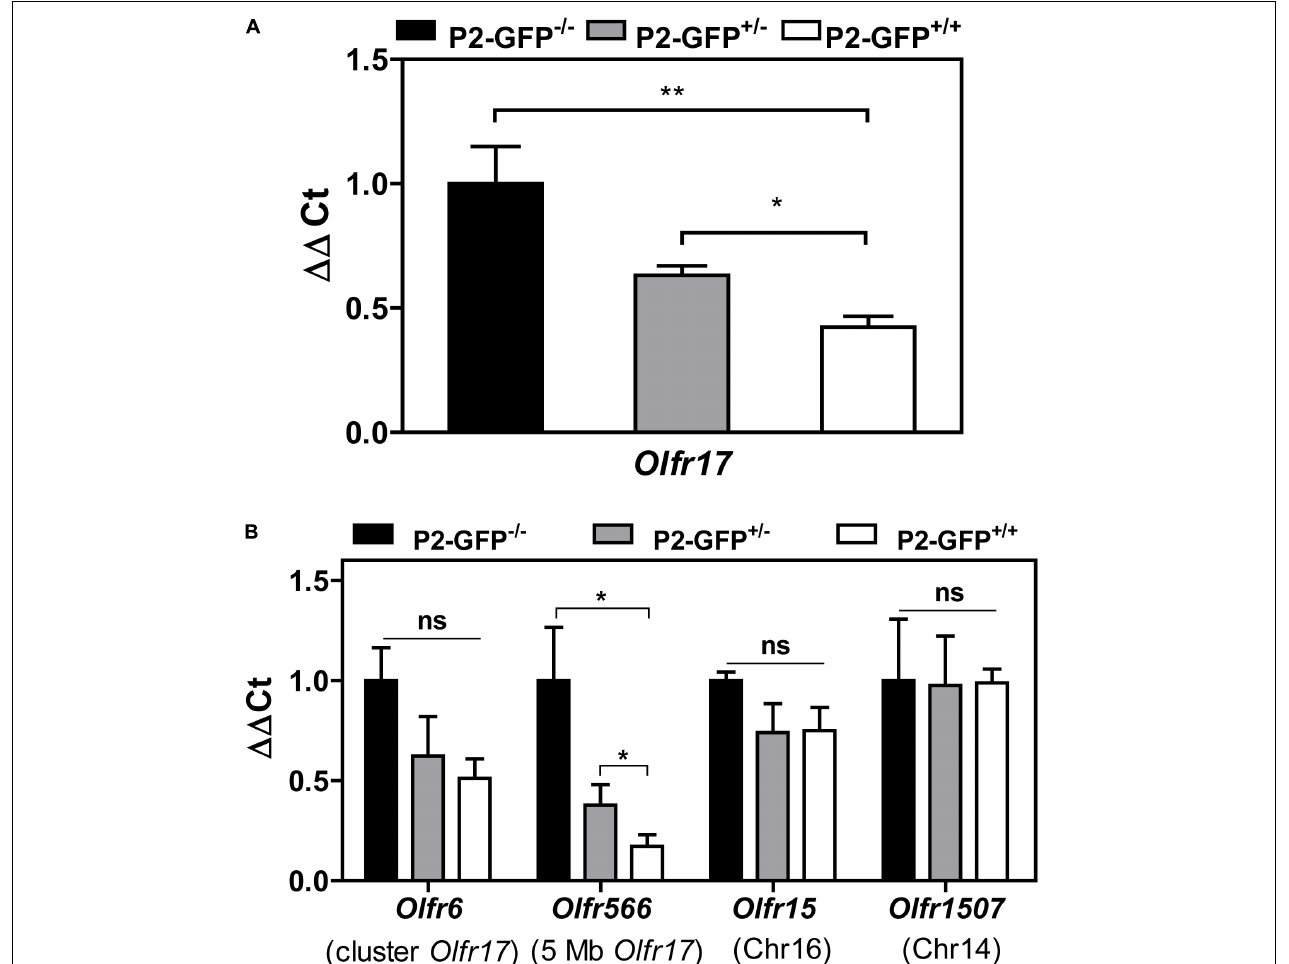
FIGURE 5 | Expression of OR genes located close to Olfr17 or in other chromosomes in the P2-GFP mice. (A) RT-qPCR was performed to determine the relative Olfr17 gene transcript levels in the olfactory epithelium from P2-GFP − / − ; P2-GFP + / − and P2-GFP + / + mice. The levels were normalized to β -actin and are shown relative to the expression in homozygous olfactory epithelium. Graph shows mean +/ − SEM (P2-GFP + / + , n = 5; P2-GFP + / − , n = 4; P2-GFP − / − , n = 5). * P < 0.05; ** P < 0.01. One-way ANOVA followed by Newman–Keuls post hoc test or student’s t -test. (B) RT-qPCR and the same cDNAs as in (A) were used to determine the relative transcript levels of Olfr6 , Olfr566 , Olfr15 , and Olfr1507 . Graph shows mean +/ − SEM [P2-GFP + / + , n = 3 ( n = 4 for Olfr6 and Olfr15 ); P2-GFP + / − , n = 4 ( n = 3 for Olfr1507 ); P2-GFP − / − , n = 3]. Not significant: ns, * P < 0.05. One-way ANOVA followed by Newman–Keuls post hoc test.